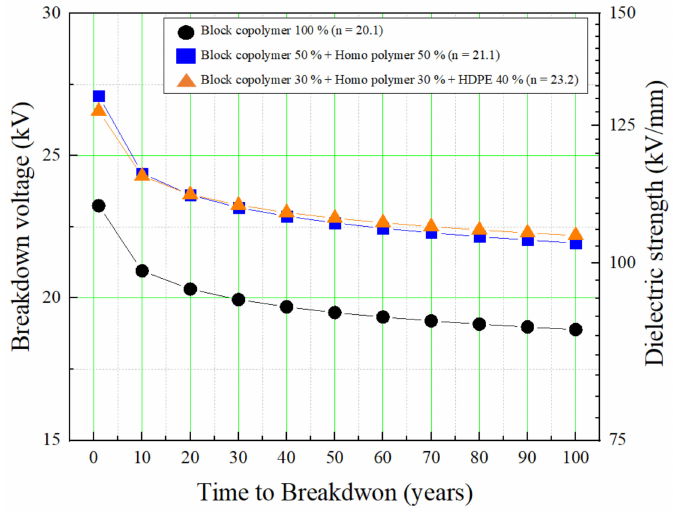
Figure 10. V-t curve considering the long term operation of power cables. Table 4. Performance evaluation of dielectric strength of PPs in 40 years. Description of the Test